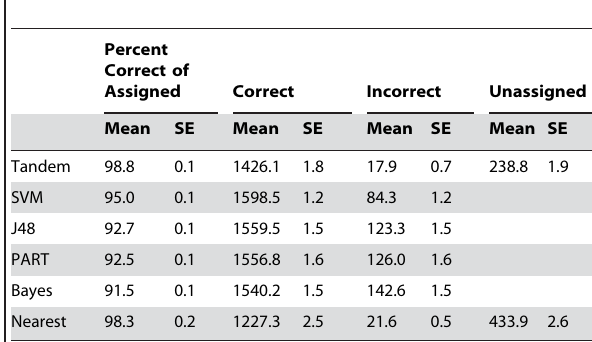
Table 1. Average classifier performance for cross-validation on our 8,414 sample ground-truth training set (see text for experiment